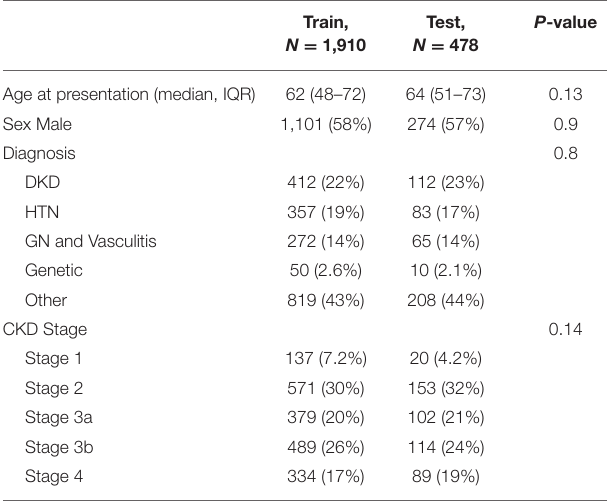
TABLE 1 | Baseline